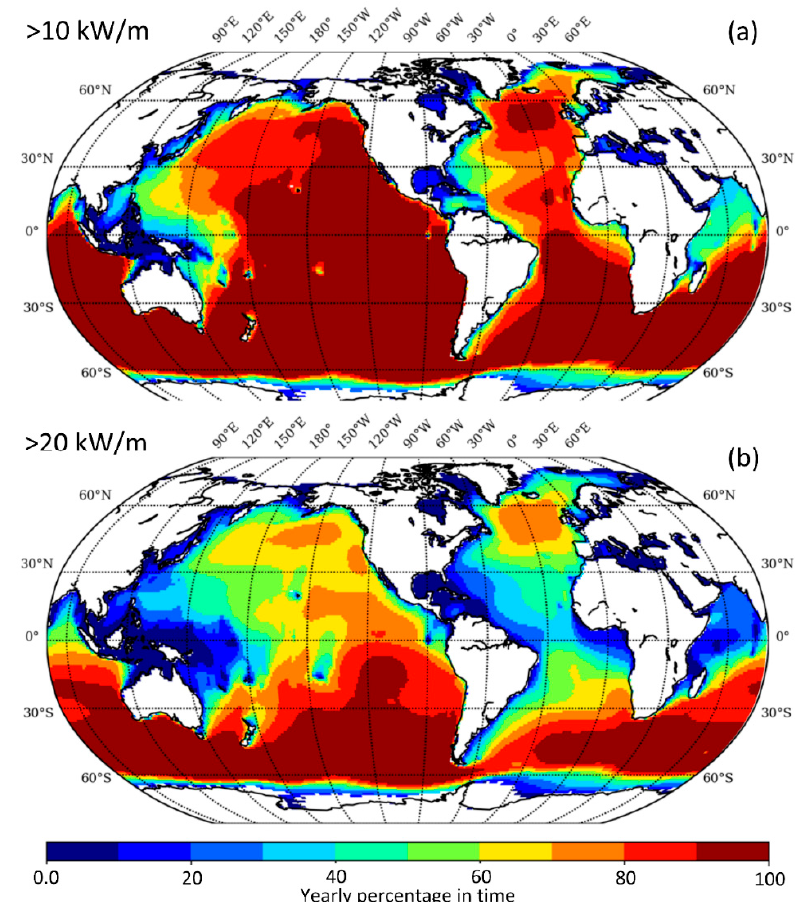
Figure 1. Yearly percentage in time of power equal or greater than: ( a ) 10 kW/m and ( b ) 20 kW/m (bottom).